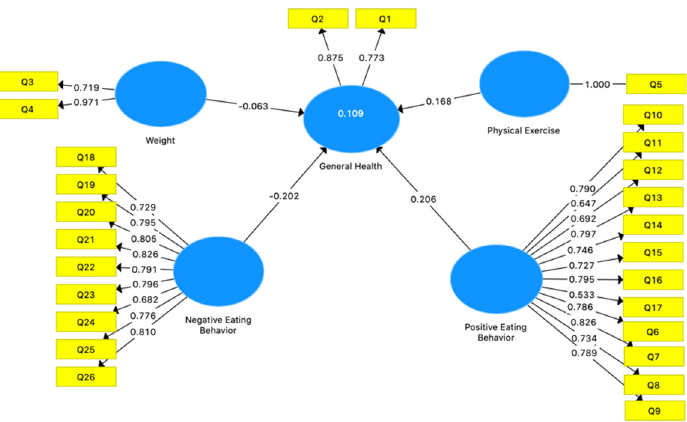
Figure 2. PLS–SEM Path Model.